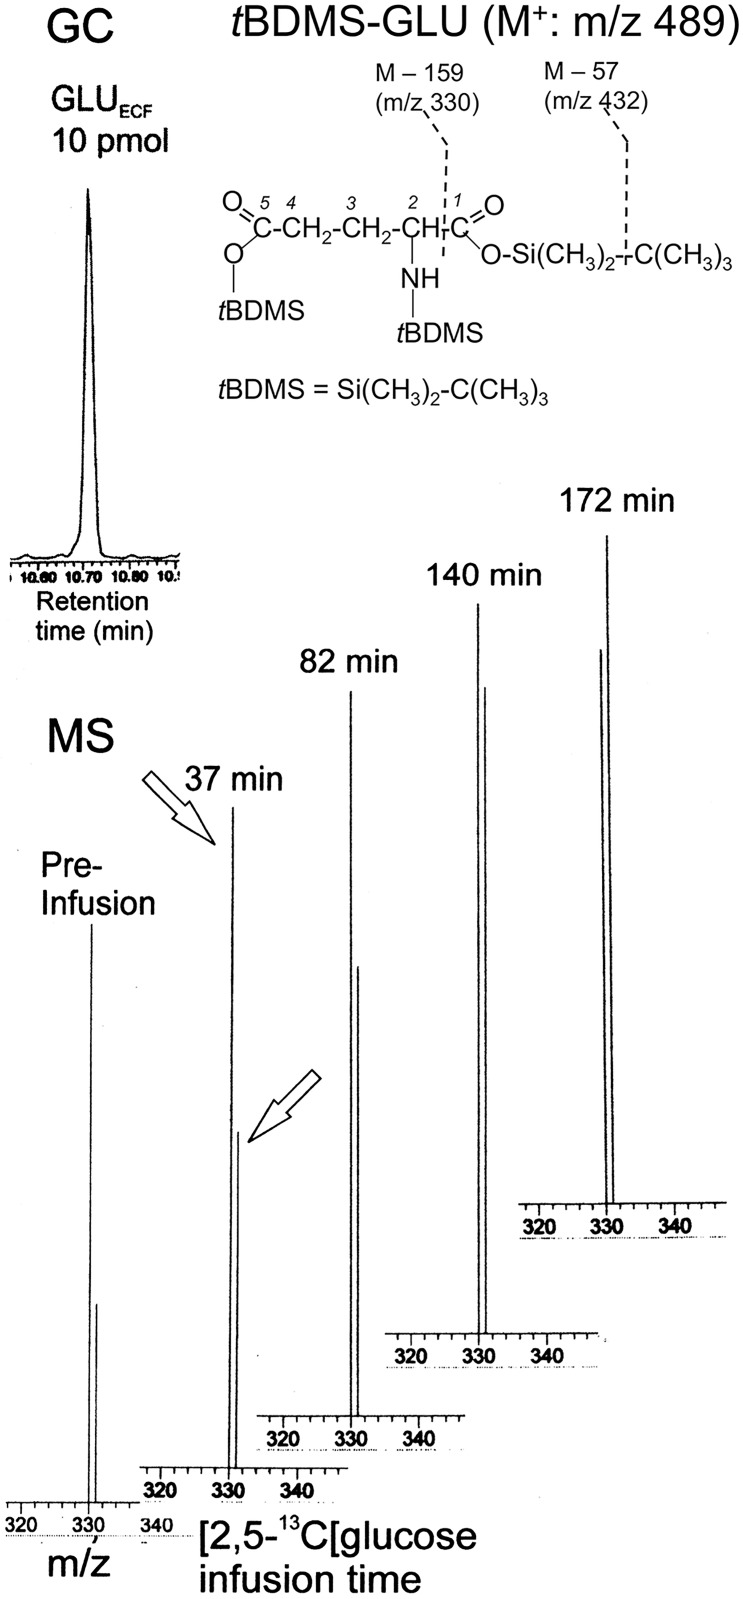
Progressive 13C enrichment of GLUECF during i.v. infusion of [2,5-13C]glucose, as observed by GCMS.The top left panel shows a GC chromatogram of 10 picomol of tBDMS-GLU. On the right are shown the structures of tBDMS-GLU and of the fragment ions m/z 432 and m/z 330. The loss of another t-butyl group from the latter gives rise to the m/z 272 ion. The bottom panel shows representative mass spectra of the ion pair m/z 330/331 of the tBDMS derivative of GLUECF (which contain C2-C5 of GLUECF) collected from the ipsilateral hippocampus of an epileptic rat (R1125 from group III) at the indicated time points during the i.v. infusion of [2,5-13C]glucose. A progressive increase in 13C enrichment was observed from the increase in the peak area of m/z 331 ion relative to that of the m/z 330 ion, shown by the arrows.